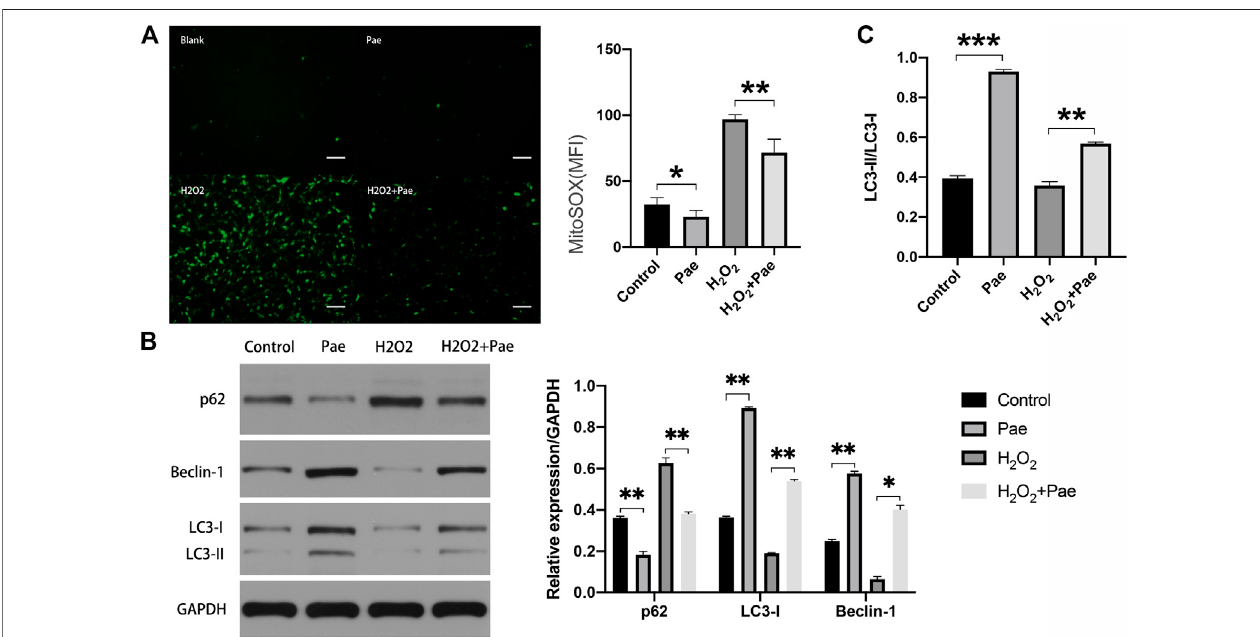
FIGURE 6 | Impact of Pae on 661 W cells under H 2 O 2 stimulation. (A) By using Mito-Sox assay, the mitochondrial ROS was determined to assess the levels of intracellularROSofeachgroup. (B) Westernblotanalysisshowedtheexpressionlevelofautophagy-relatedproteins. (C) TheratioofLC3-IItoLC3-Iwaspresented.The ratio was higher in Pae group comparing with in Control group and was higher in H 2 O 2 + Pae group than H 2 O 2 group. Data show mean ± SD. ( n (cid:1) 6 – 9 for each group) * p < 0.05, ** p < 0.01, *** p < 0.001. Scale bar: 100 μ